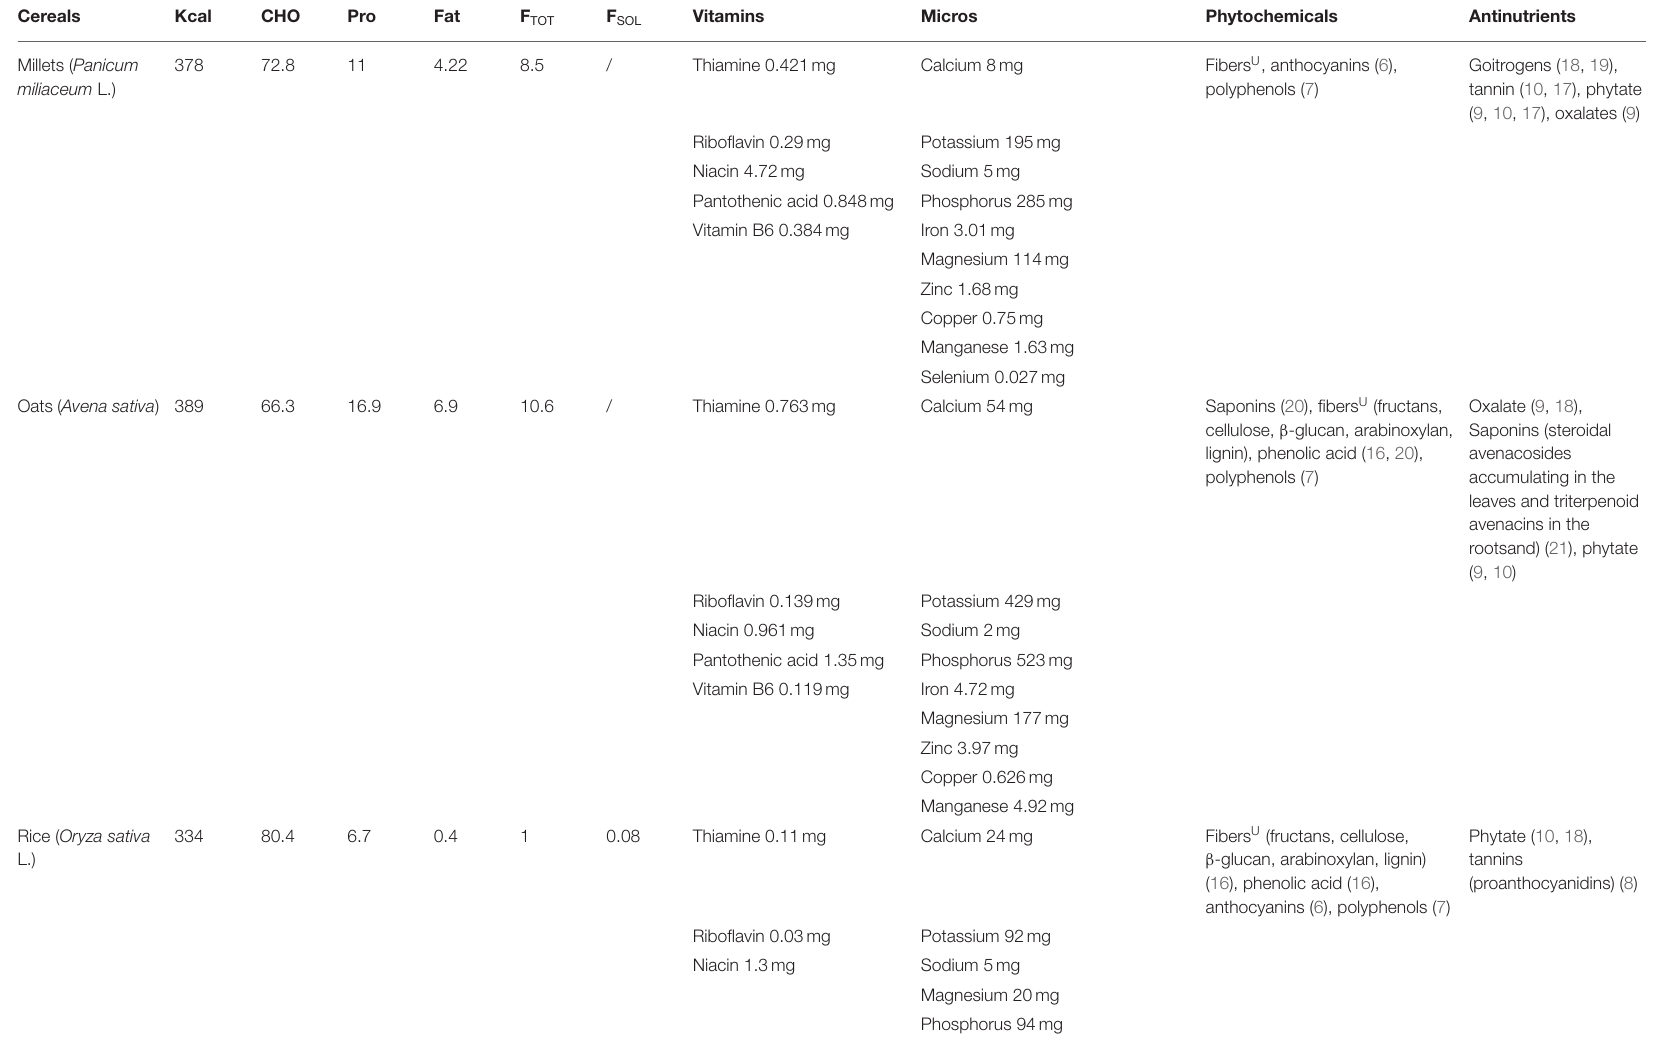
Cereals Kcal CHO Pro Fat F TOT F SOL Vitamins Micros Phytochemicals Antinutrients Millets ( Panicum miliaceum